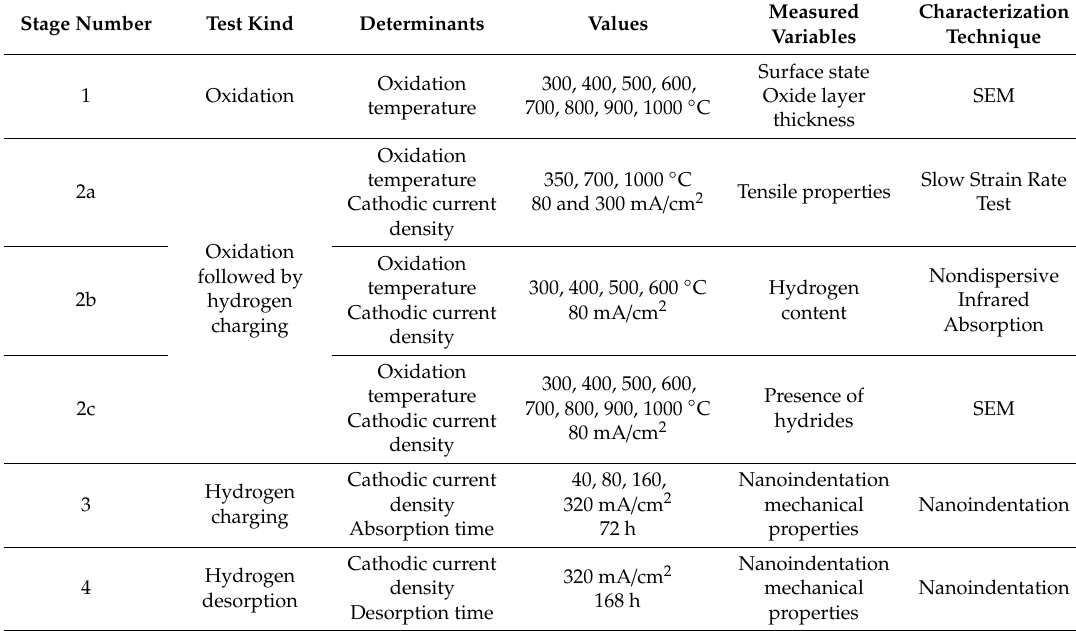
Table 1. Experimental